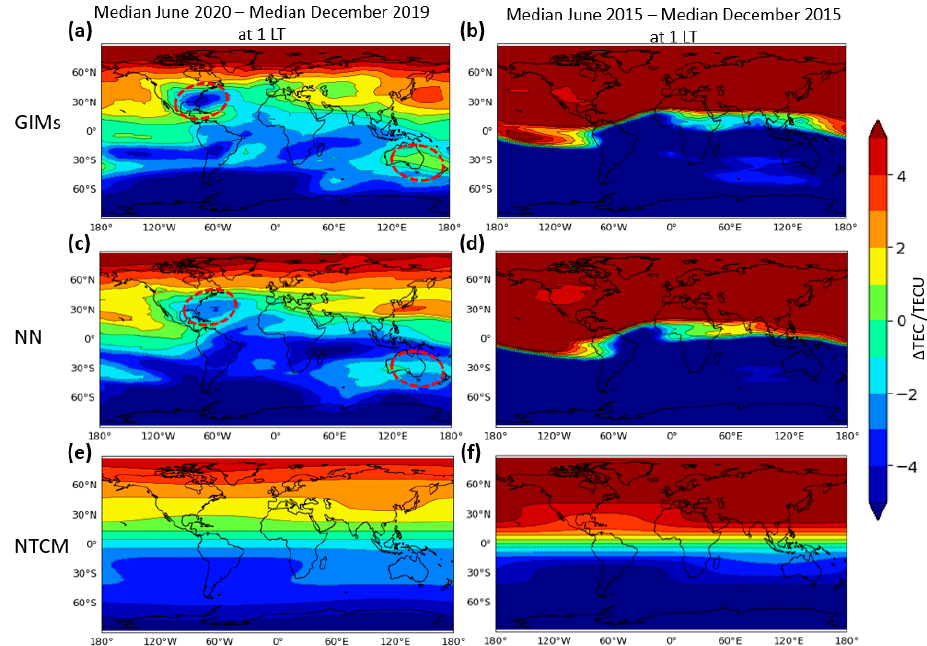
Figure 8. The differential GIM VTEC data ( a , b ), NN model predictions ( c , d ), and the NTCM predictions ( e , f ) for the LSA in 2020 and HSA in 2015. The NWA is highlighted with the red dashed circles.